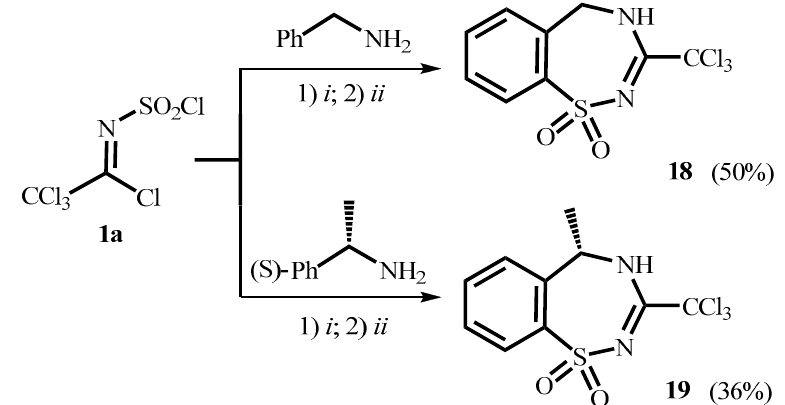
Figure 6. Molecular structure of 4,5 ‐ dihydro ‐ 1,2,4 ‐ benzothiadiazepine ‐ 1,1 ‐ dioxides 17a , b , 18 , 19 including thermal displacement ellipses with 50% probability.